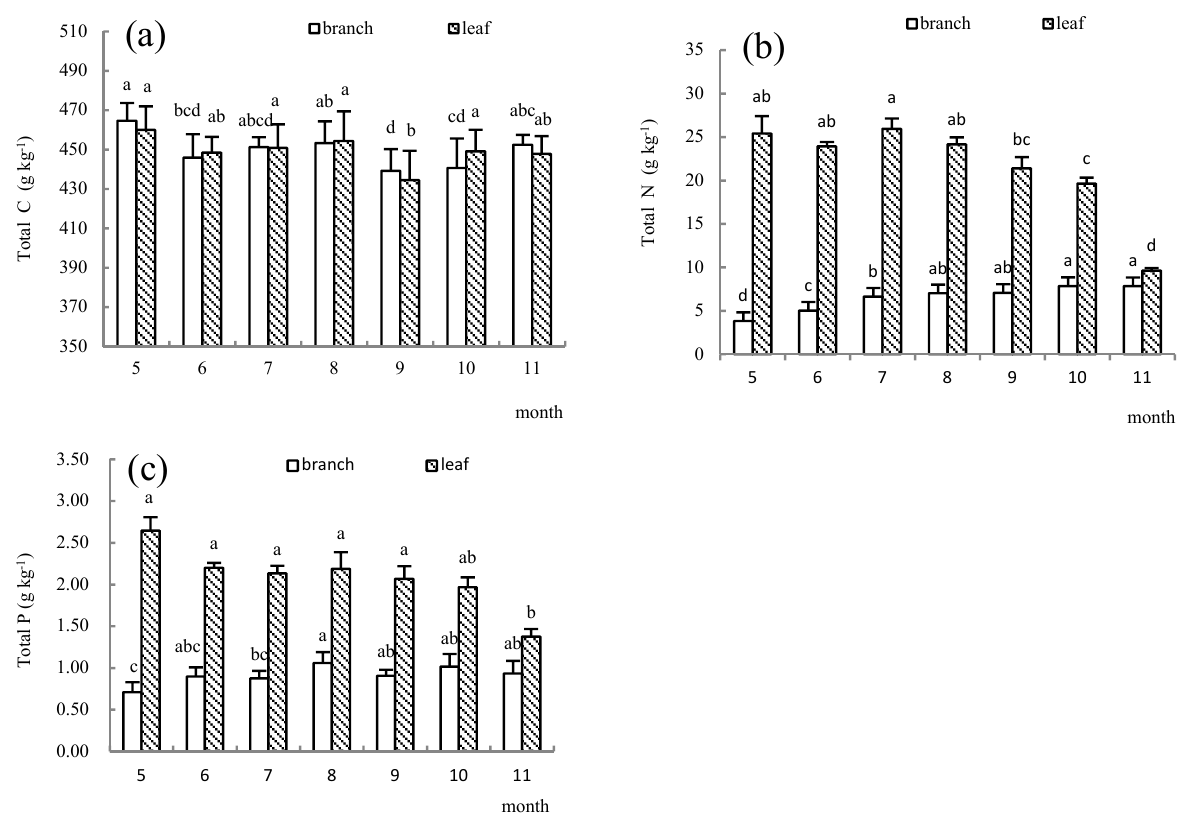
Figure 2. Monthly dynamic of C ( a ), N ( b ), P ( c ) contents in different organs of male plants of F. velutina . Note: Means of different months not sharing the same letter indicated significant differences at an alpha level of 0.05, according to an LSD test.